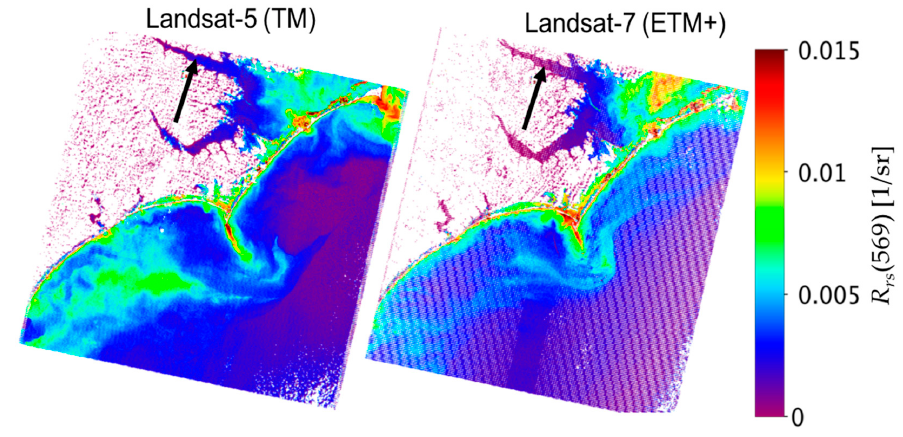
Figure 7. Scene-wide R rs (569) and R rs (560) products derived from TM ( left ) and ETM+ ( right ) over the North Carolina shorelines and Pamlico Sound (USA). The images were acquired eight days apart on 18 September (TM) and 26 September 2006 at about 15:30 GMT. Large gradients, i.e., relatively clear coastal shelf waters, eddies, resuspensions, CDOM-dominated waters and bottom features, are captured in the two images. The CDOM-rich waters of Tar/Pamlico Rivers are indicated with arrows. Note that negative retrievals do exist in such challenging waters in the ETM+ product [72] and a 7 × 7-element (uniform) averaging filter was applied in the aerosol removal process.